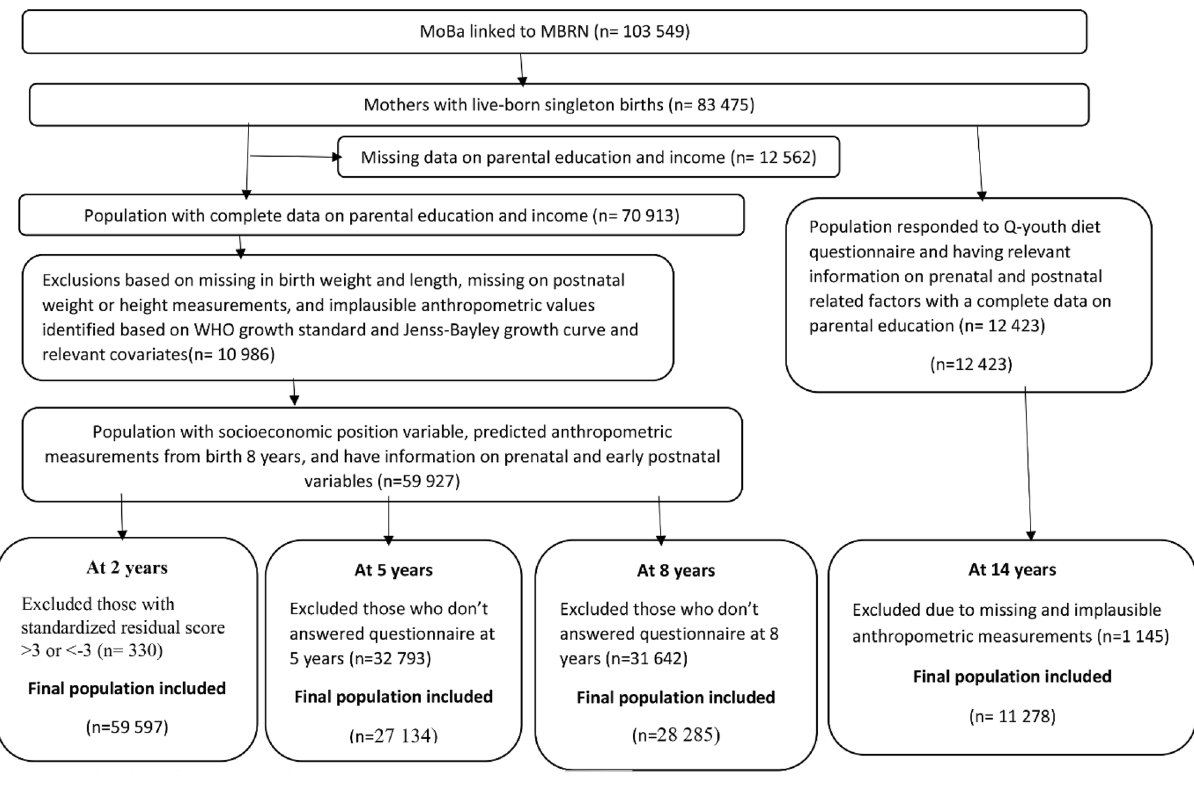
Figure 1. Flow chart of the study